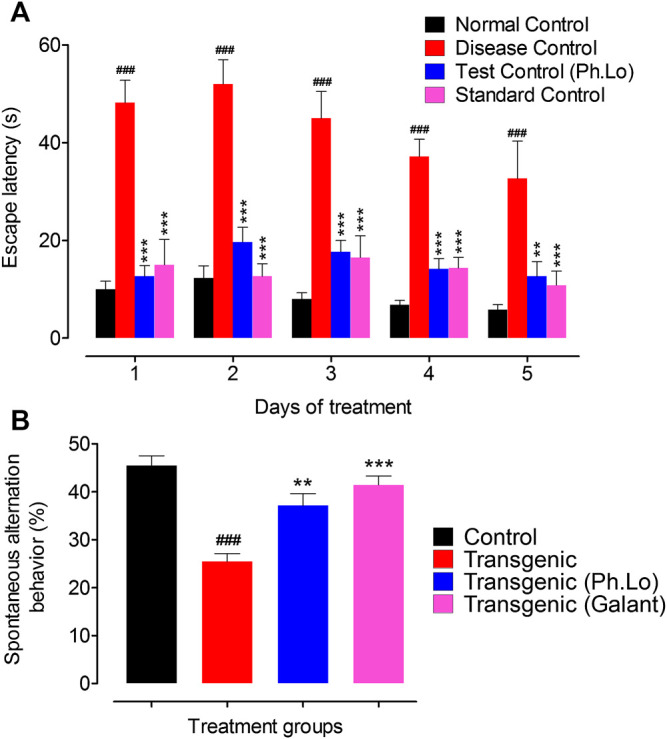
Y-maze test on various groups of animals. (A) Escape latency (sec). (B) Spontaneous alternation behavior (%). Each value represents an average ± SEM of three independent experiments. **, ##: p < 0.01; ***, ###: p s < 0.001.